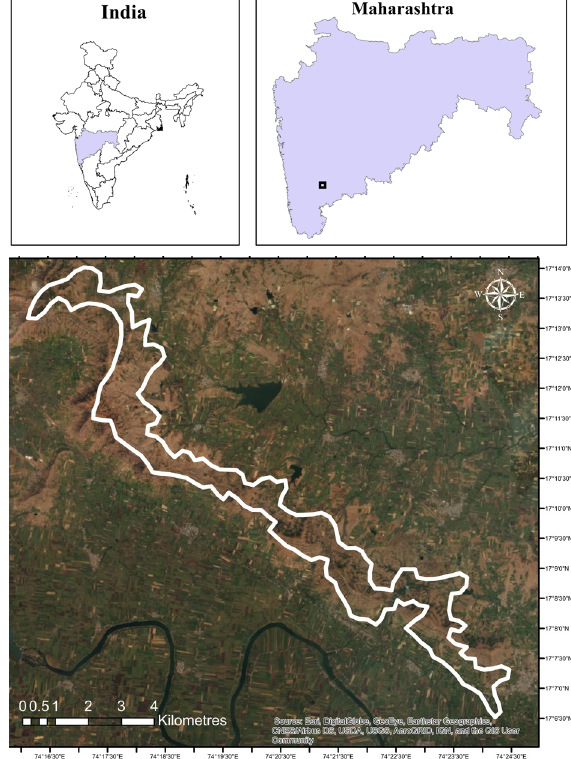
Figure 1. Sagareshwar Wildlife Sanctuary, Sangli District, Maharashtra,